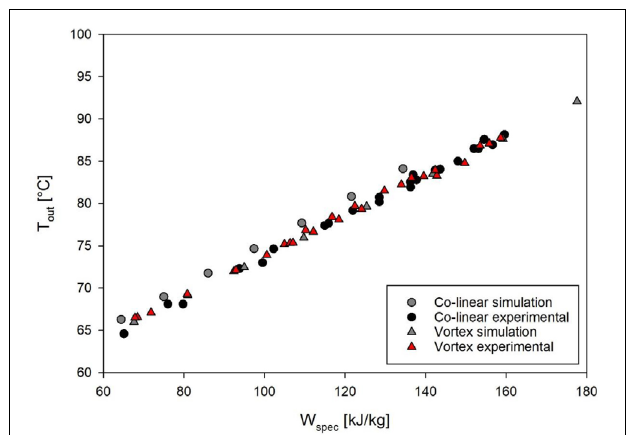
FIGURE 6 | Comparison of outlet temperatures and specific energy input, as determined by experiments and simulation. Depicted experimental data points are derived from all accomplished trials with M. lacticum and ALP, respectively. Corresponding process parameters are given in Table 3 .